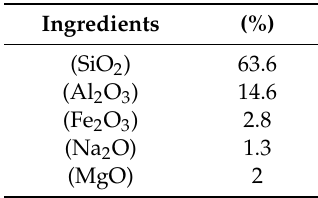
Table 2. Chemical properties of bentonite